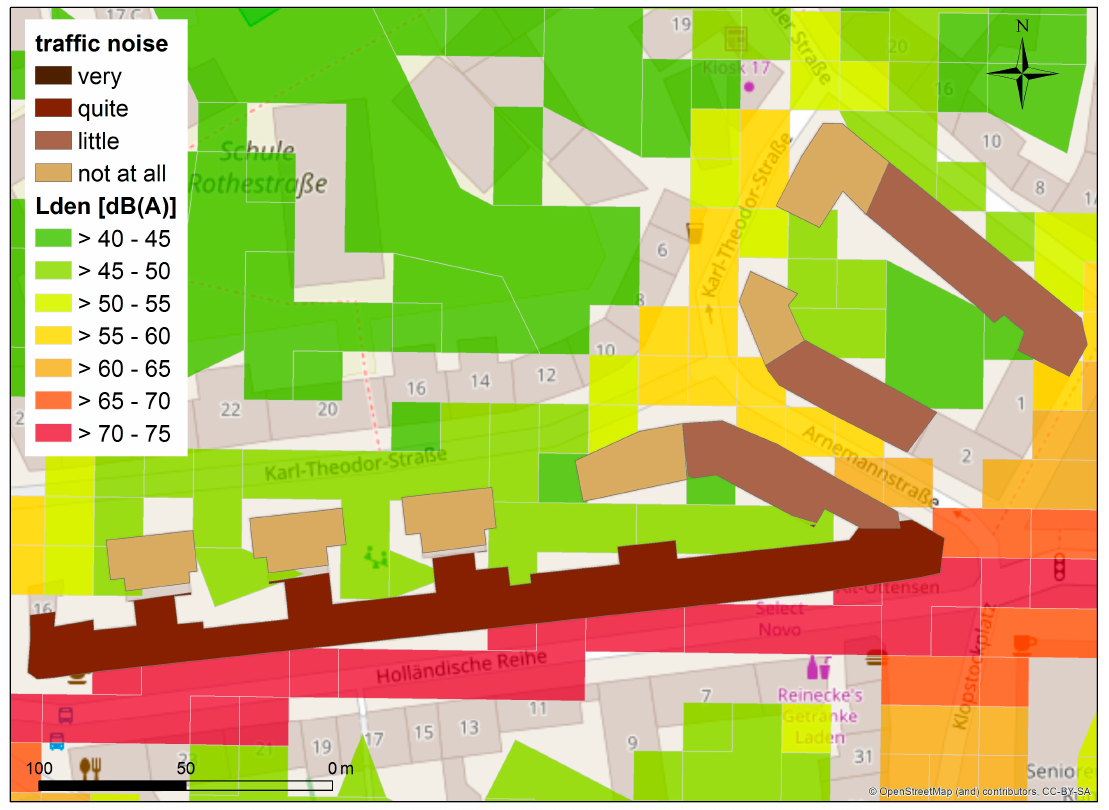
Figure 6. Subjective rating of annoyance by traffic noise in Subarea 6 data L den [54].